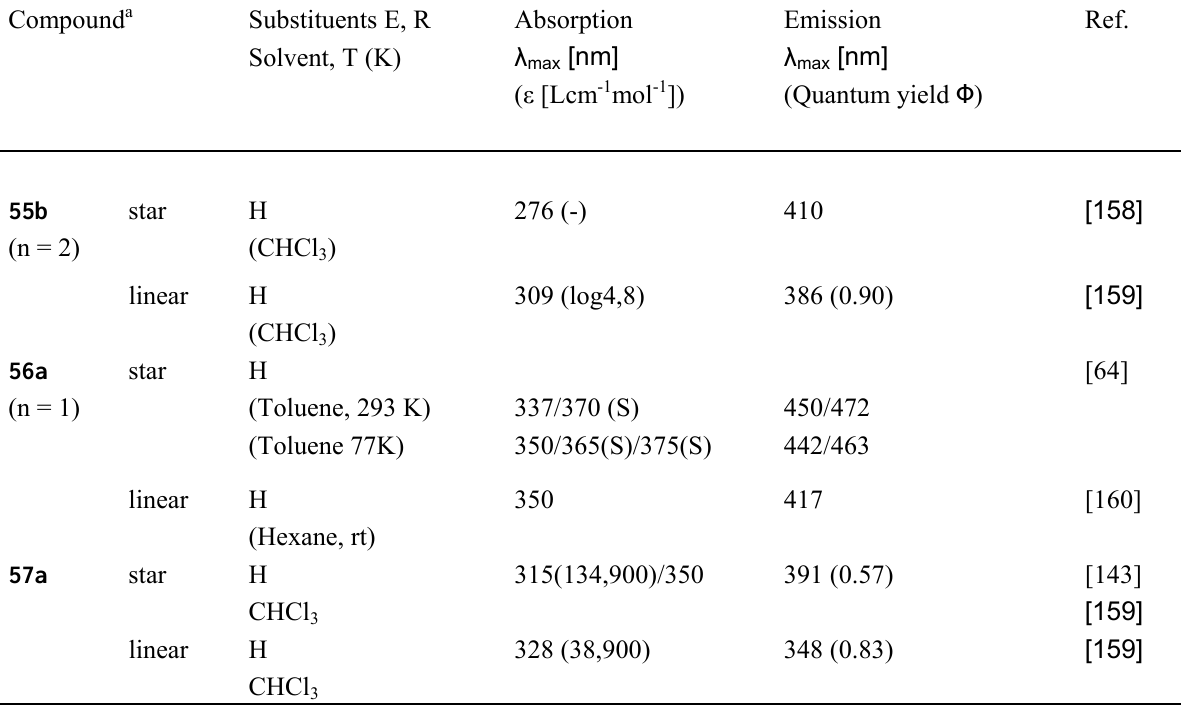
Table 4. Photophysical data of cross-shaped conjugated star